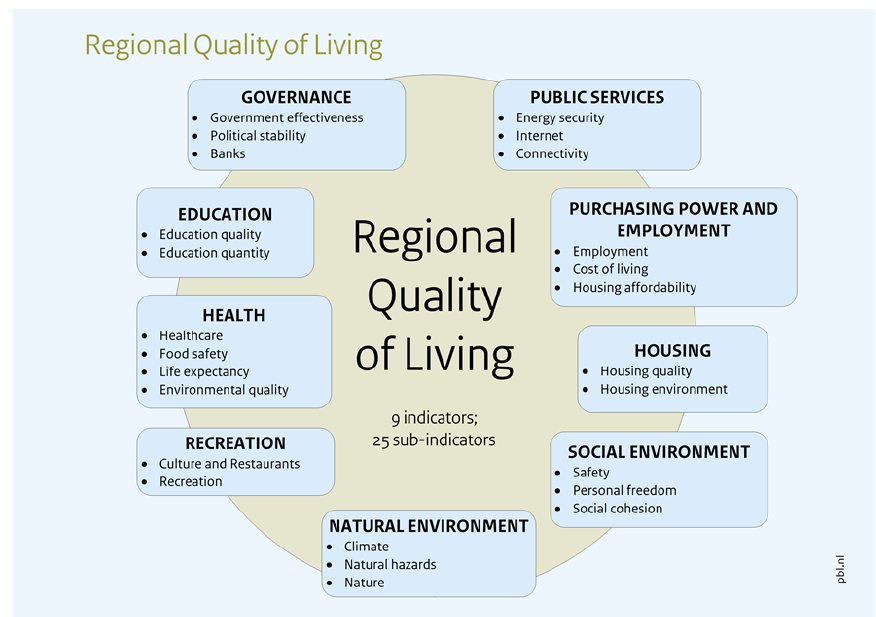
Figure 1: Indicators and sub-indicators to characterize the Quality of Living